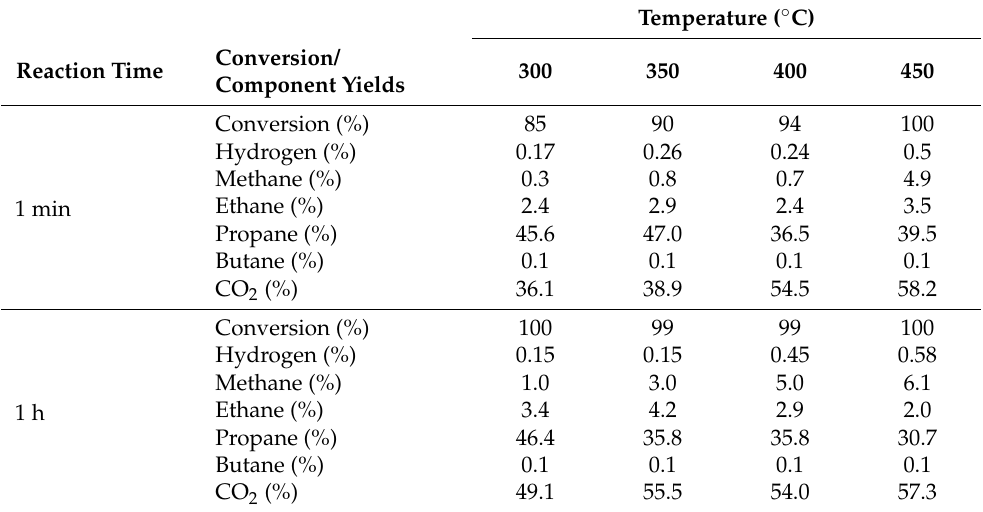
Table 2. Effect of temperature on the butyric acid conversion and gas yields from reaction times of 0